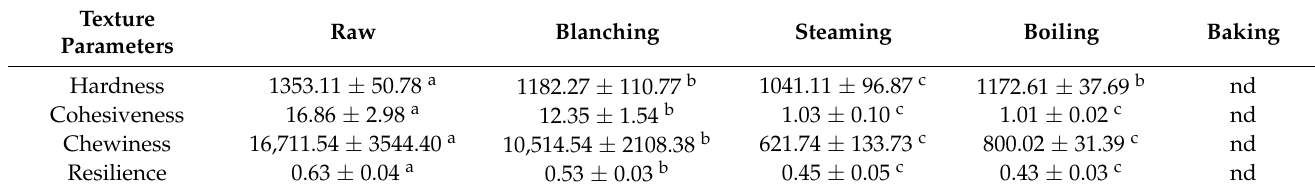
Table 2. Influence of different cooking methods on the texture of U. pinnatifida .